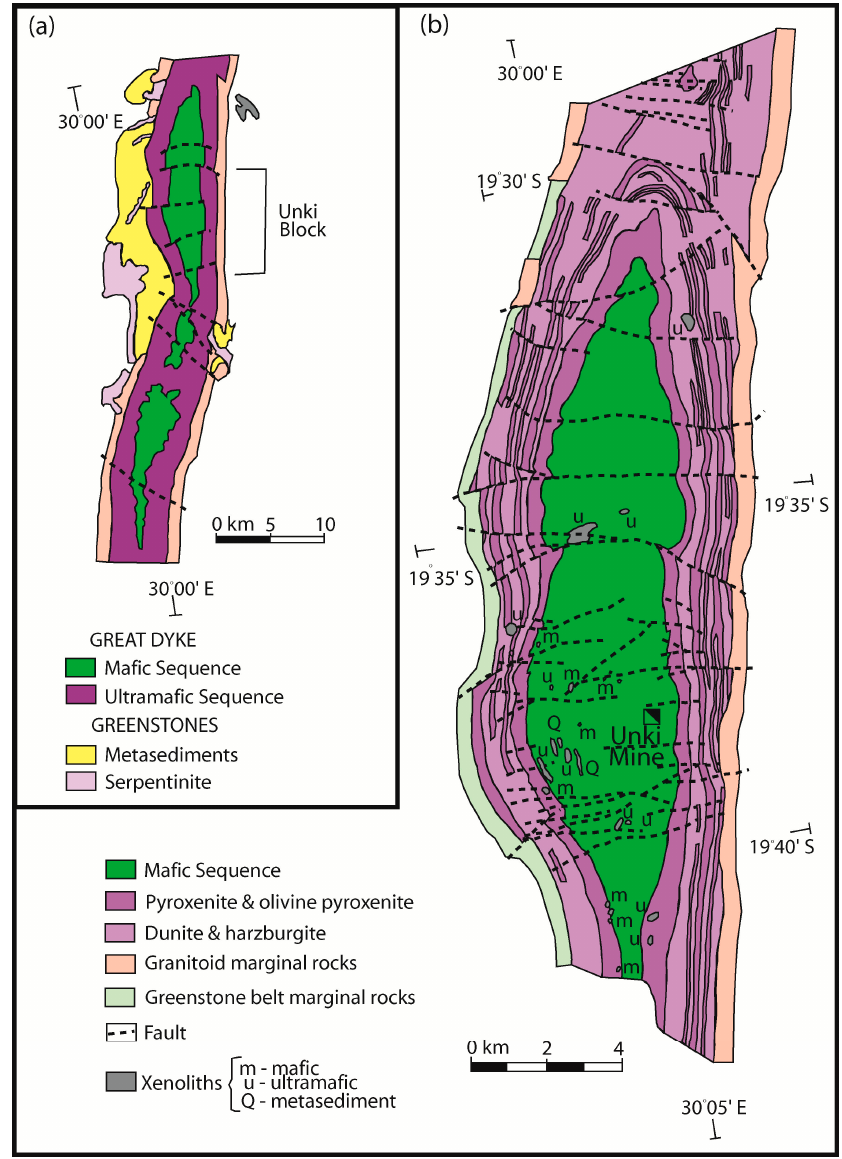
Figure 4. Map showing the geology of the north-central zone of the Shurugwi Subchamber (after Wilson et al., 2000) [30]. Insert ( a ) with various mining blocks indicated shows location of a simplified map of the Shurugwi greenstone belt on west contact of the subchamber. The main map ( b ) is an outcrop map covering the Unki Block and parts of Paarl and Helvetia Blocks. Fragments of xenolithic and autolithic suite within the Great Dyke are also shown. Cyclic Unit 1 of the Darwendale Subchamber contains several zones of sulfide mineralization [27,40]. Cyclic Unit 1 (Figure 3) is 420 m thick at the axis of the Dyke in the Darwendale Subchamber and comprises a number of subunits defined on the basis of narrow chromitite layers, repeated stratigraphy, and reversals in mineral compositions [31]. Bichan (1970) [40] identified sulfide mineralization within the lower subunits, with the main metal zones occurring in Sulfide Zones l (i),